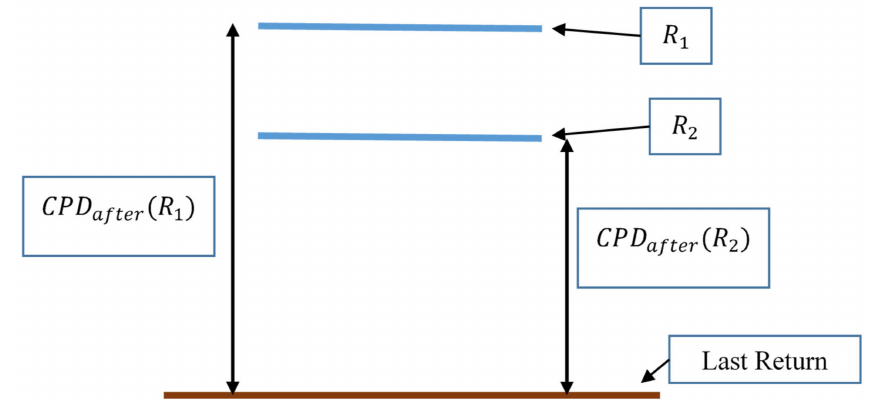
Figure 8. The CPD after ( R 1 ) is the integrated waveform after the top of the voxel, while CPD after ( R 2 ) is the integrated waveform after the bottom of the